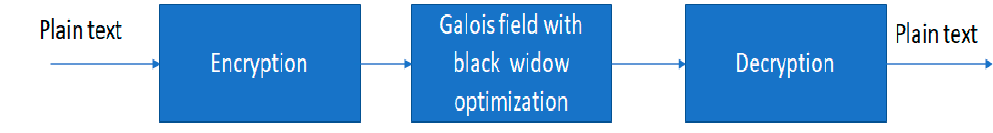
Figure 1. Cryptographic Processing.